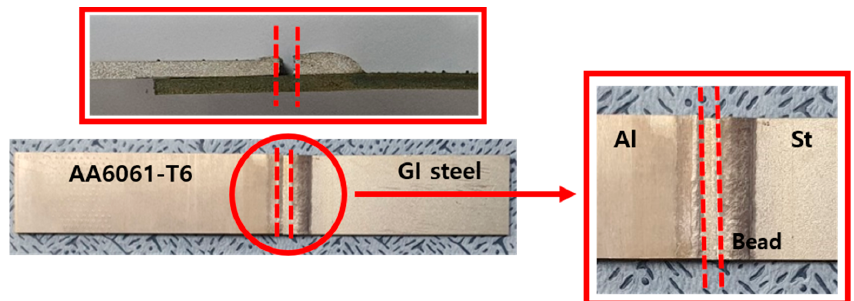
Figure 6. Typical fractured surface of braze-welded joints after tensile shear test.